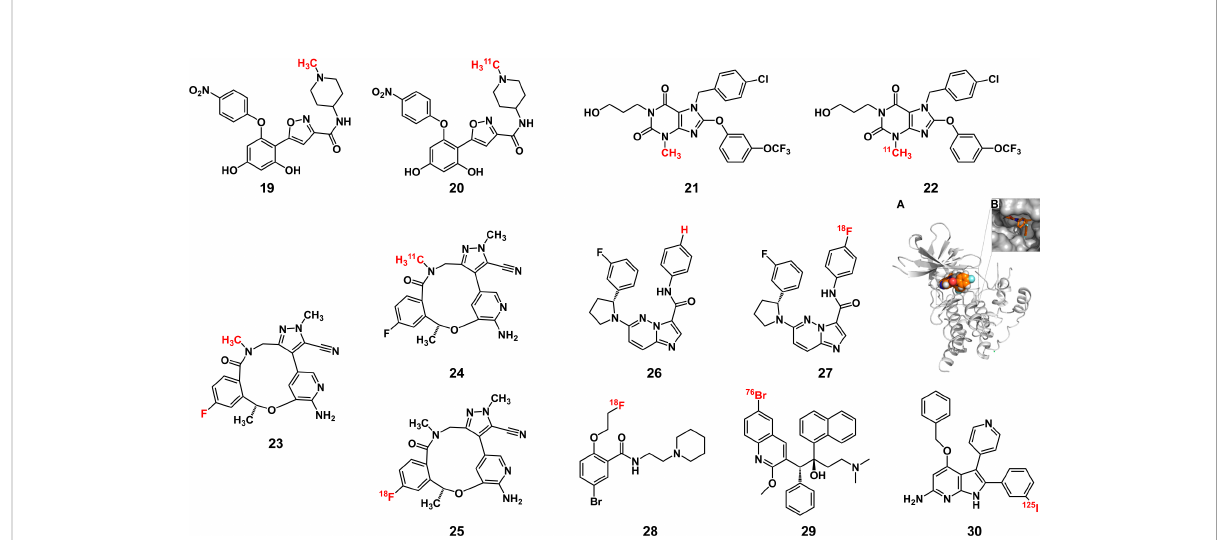
FIGURE 6 Some structures of radiolabeled AfPIs with nonmetallic radionuclide labels(Red: radionuclide labels). (A, B) The molecular docking result of [ 18 F] labeled TrkA inhibitor with TrkA protein showed that the labeled inhibitor could bind with Trk. Reprinted with permission (84). Copyright 2018 American Chemical